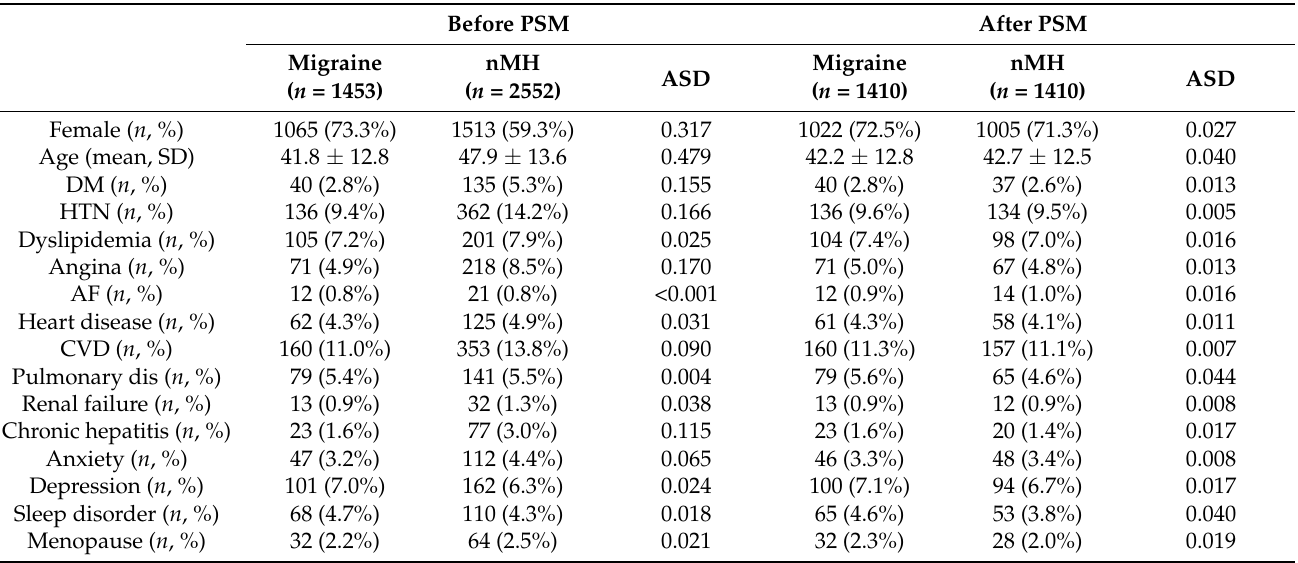
Table 3. Clinical characteristics of the migraine and non-migraine headache groups before and after PSM.